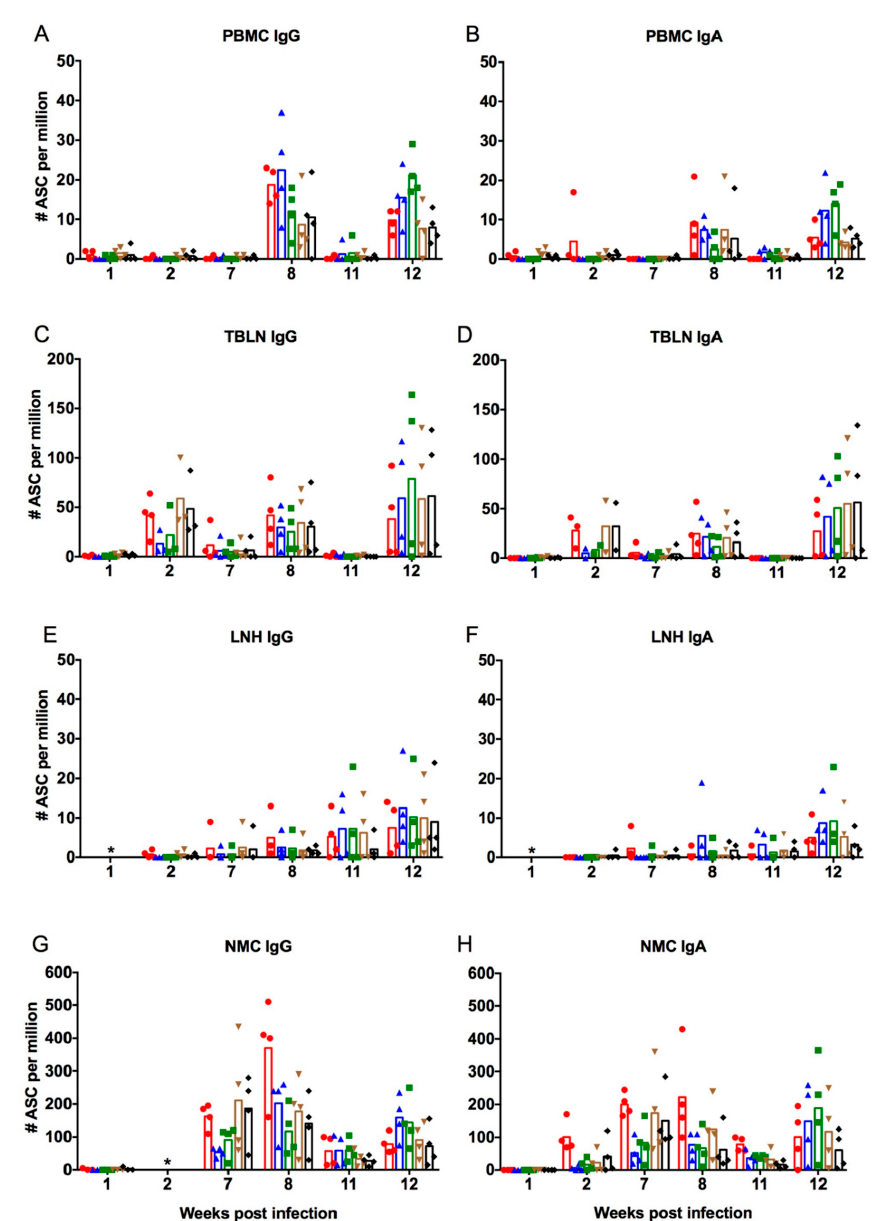
Figure 3. Numbers of virus-specific IgG and IgA antibody-secreting cell (ASC) in peripheral blood mononuclear cells (PBMC) ( A , B ), tracheobronchial lymph nodes (TBLN) ( C , D ), lymph nodes of the head (LNH) ( E , F ), and nasal mucosa (NMC) ( G , H ) for each individual pig after infection with NC95 and vaccination with PA10 followed by G08. Responses in the different tissues were examined at weeks 1, 2, 7, 8, 11, and 12 after infection. The first and second vaccinations were performed at weeks 7 and 11, respectively. Symbols represent responses of four individual pigs, which were examined at each time point. The mean numbers of ASC are shown by the bars. The different colors represent responses against the five different viruses ( NC95; PA10; G08; VIC75; HK14). The asterisk (*) means that ASC responses were not examined at that particular time point.